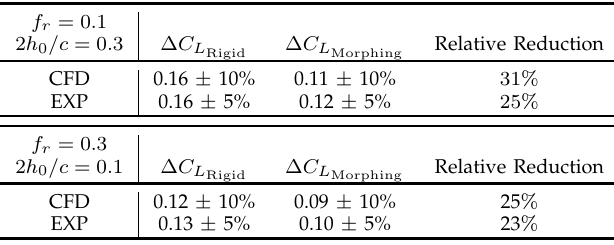
Fig. 8: Amplitude of the lift coefficient fluctuations ( ∆ C L ) of the rigid foil and that with a passive flap at three reduced frequencies, f r = 0 . 1 , 0.3 and 0.5 and three heaving displacements 2 h 0 /c = 0 . 1 , 0.3 and 0.5. The experimental uncertainty of the measured ∆ C L is ± 5%. The solid line shows ∆ C L predicted by Theodorsen’s theory, whilst the solid-dotted line the one predicted by the model presented in Sec. III-E. TABLE I: Amplitude of the lift coefficient fluctuations ( ∆ C L ) of the rigid foil and that with a passive flap predicted by CFD and experiments. Uncertainty is indicated for the 95% confidence